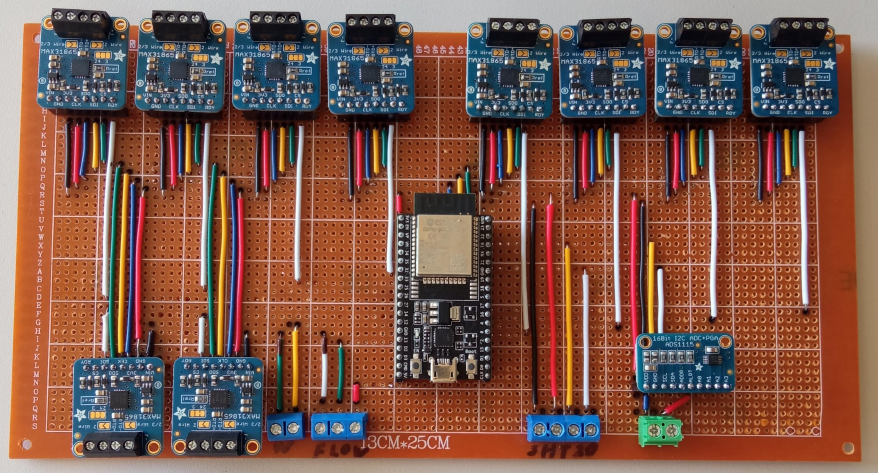
Figure 5. Data logger prototype board.